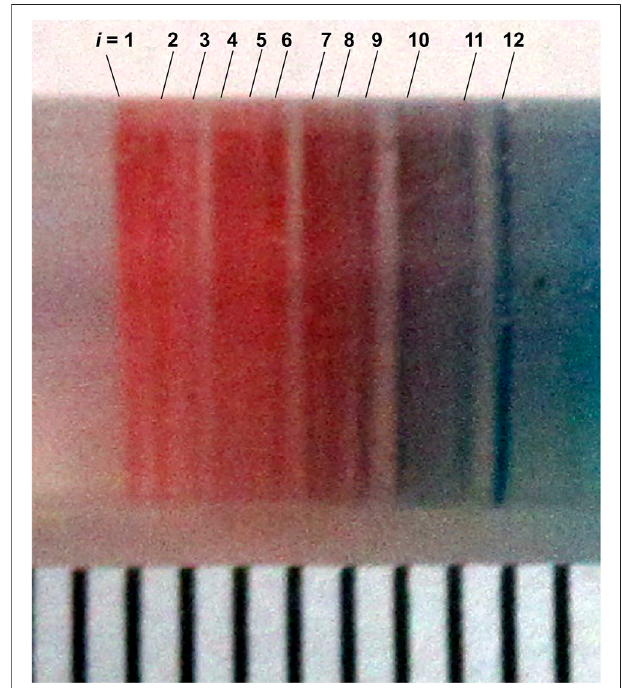
FIGURE 10 | Enlarged image of the periodic bands shown in Figure 9A after removing unreacted ions and soluble compounds. The bands are numbered from 1 (the cathode side) to 12 (the anode side). For comparison, 1 mm graduations are also shown at the bottom of the